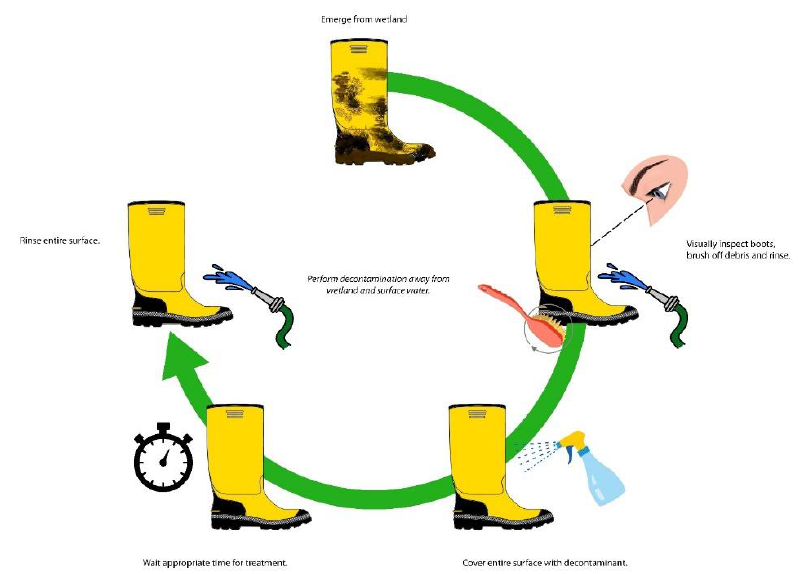
Figure 3. Decontamination steps for boots and equipment before and after entering a wetland. Treat- ment time varies depending on target organisms but for bleach, which is useful in most situations, a minimum of 5 min is suggested at 10% concentration (Table 1, Supplementary Materials Table S1). Decontamination procedures should occur about 200 m away from the wetland to avoid inadvertent contamination. Table 3. Managers and researchers should coordinate procedures for all activities before, during, and after site visits. These activities should reflect all preventative measures for the appropriate Tier and those below it.